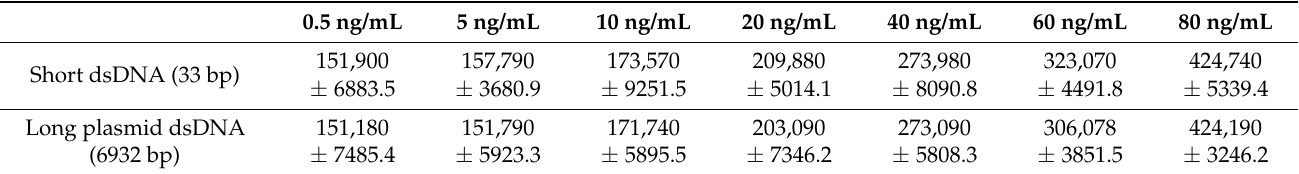
Table 1. The Fluorescence intensities of the QDs-Ru complexes were adding dsDNA fragments with different sequence lengths and different concentrations.